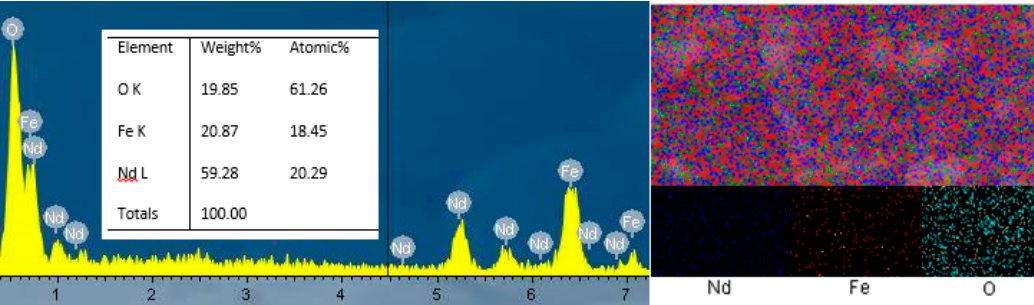
Figure 6. Energy-dispersive X-ray spectroscopy (EDX) (left) and EDX-mapping spectrums (right) of NdFeO 3 nanoparticles annealed at 750 °C for 1 h.